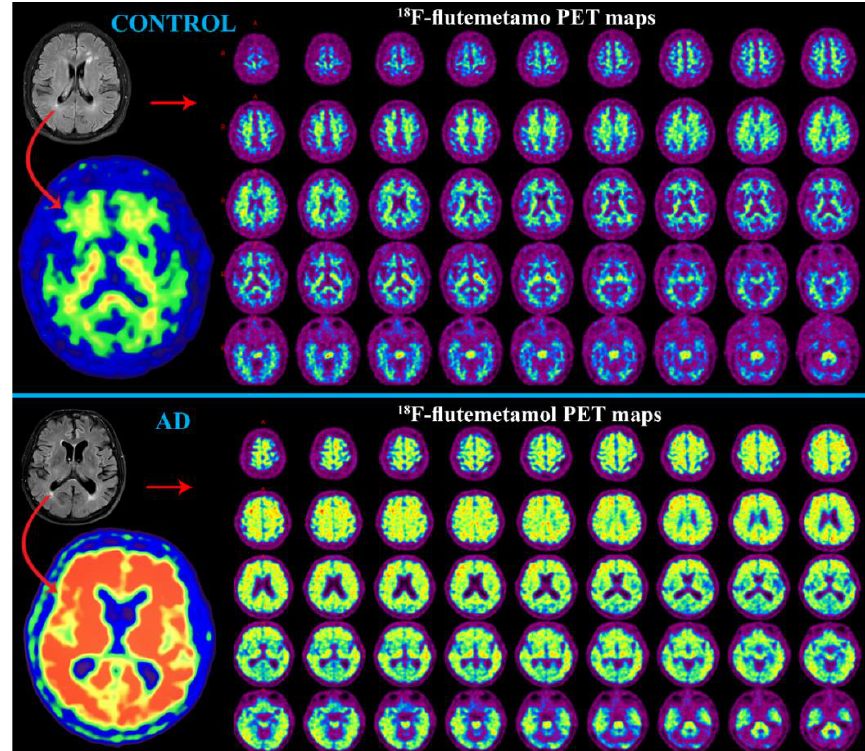
Figure 6 . Example of 18 F-flutemetamol (Vizamyl) PET neuroimaging of a control subject Figure 6. Example of 18 F-flutemetamol (Vizamyl) PET neuroimaging of a control subject (73-year-old (73-year-old male) and AD patient (72-year-old male). Note the visualization of subtle male) and AD patient (72-year-old male). Note the visualization of subtle cortical atrophy with enlarged ventricles (T 1 -weighted MRI at 3 Tesla MR-scanner) and increased retention of the Vizamyl radiotracer demonstrating the presence of A β deposition in the AD brain tissue, compared with that of the control